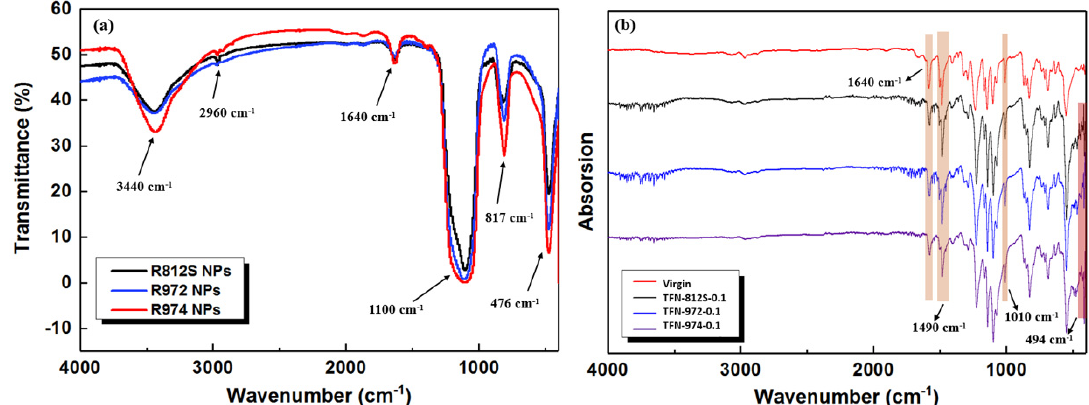
Figure 8. SAXS spectra of membranes with different concentrations of R812S NPs.